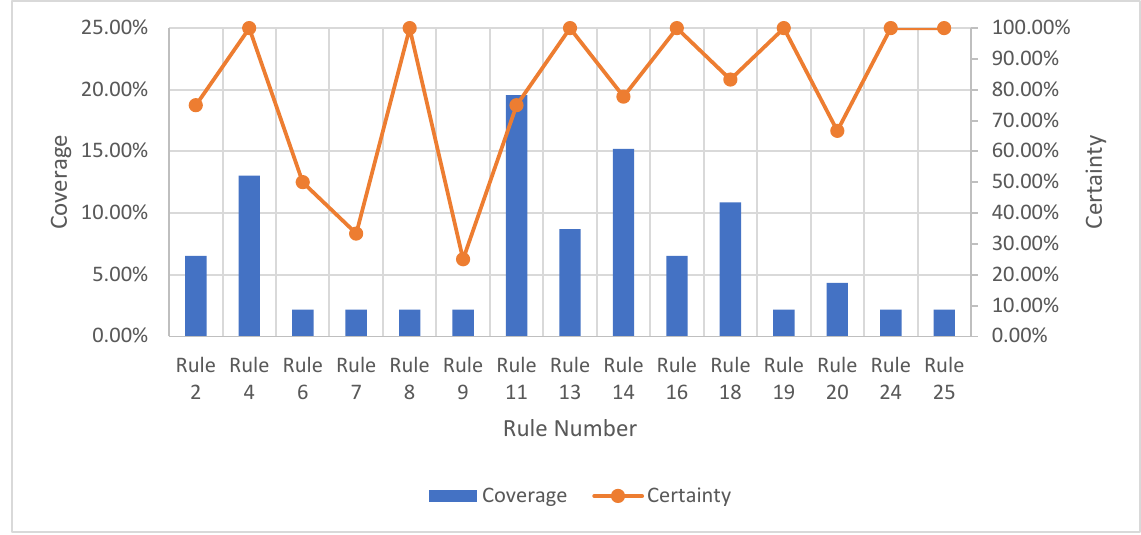
Figure 2. Results of rules generated for decision class 1 in the validation set.